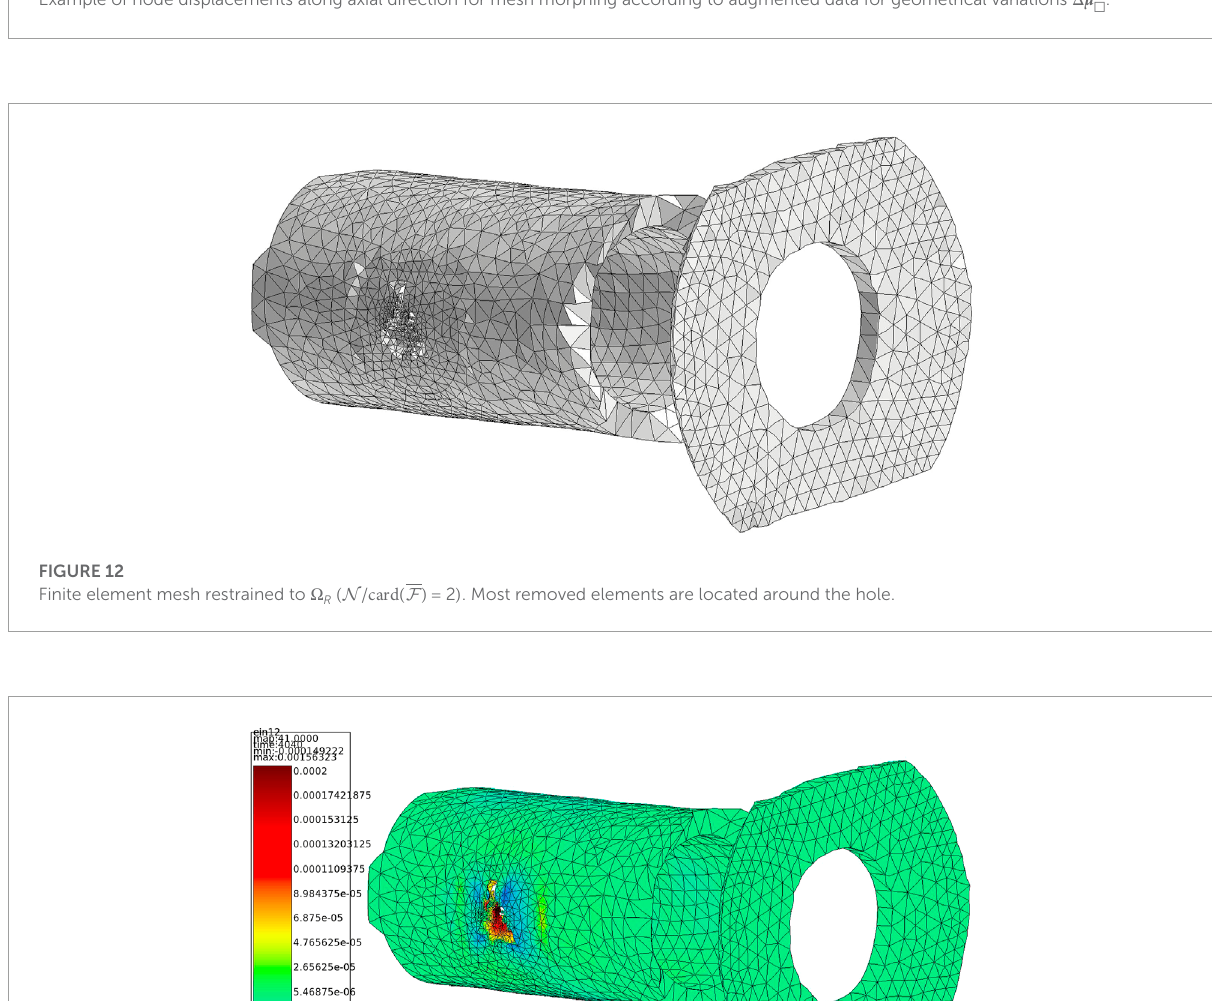
FIGURE 11 Example of node displacements along axial direction for mesh morphing according to augmented data for geometrical variations Δ μ □ .